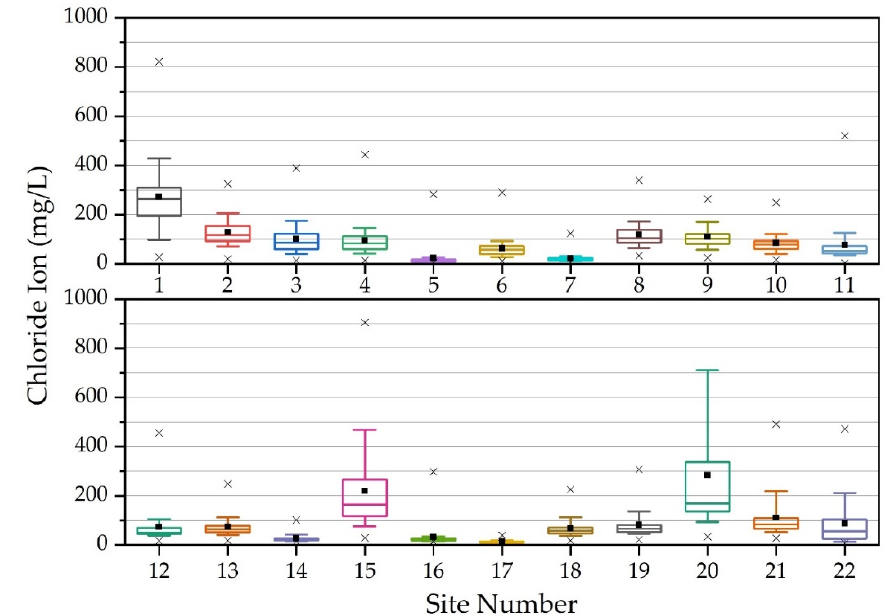
Figure 8. Box and whisker plot of chloride ion (mg/L) descriptive statistics at 22 sampling locations during study period (2 January 2018–1 January 2019) in West Run Watershed, Morgantown, WV, USA. Box delineates 25th and 75th percentiles; line denotes median; square shows mean; whisker describes 10th and 90th percentiles; x shows maximum and minimum when above and below, respectively.